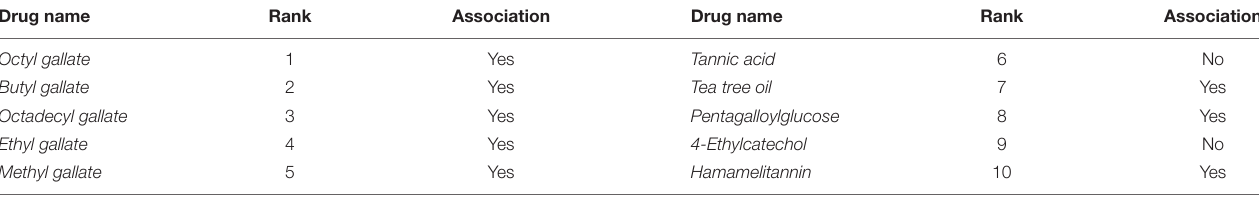
TABLE 3 | The associations among Staphylococcus aureus and ten drugs. Drug name